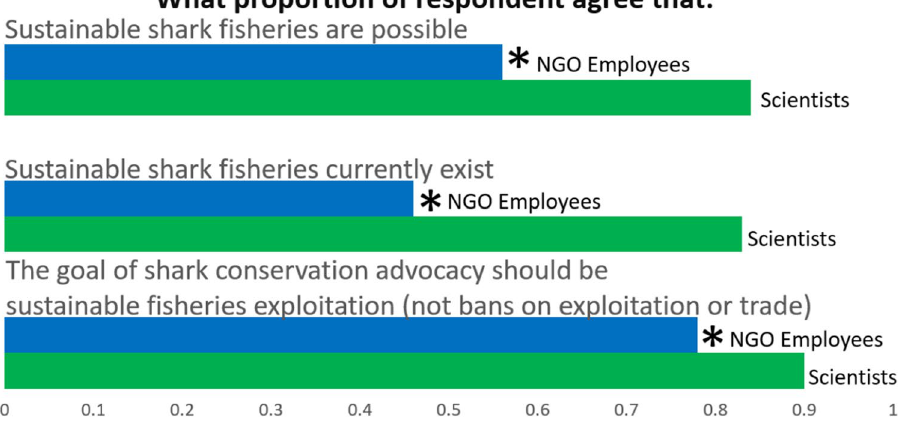
Figure 3. Proportion of environmental advocate respondents from this study (blue) and scientists respondents from Shiffman and Hammerschlag 2016B (green) who agree with these three questions, with * indicating a significant difference in responses to each question between the two groups using a 2-tailed Z test of independent proportions (for Question 1, Z = − 3.66, P = 0.0003, for Question 2, Z = − 4.48, P < 0.00001, for Question 3, Z = − 1.87, P = 0.03).